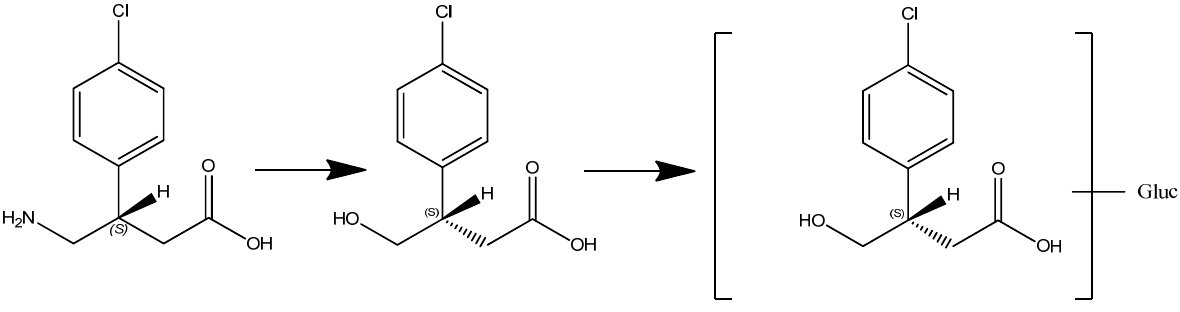
Figure 9. Enantioselective metabolism of racemic baclofen into S-hydroxy baclofen (metabolite M1) and conjugated glucuronide (metabolite